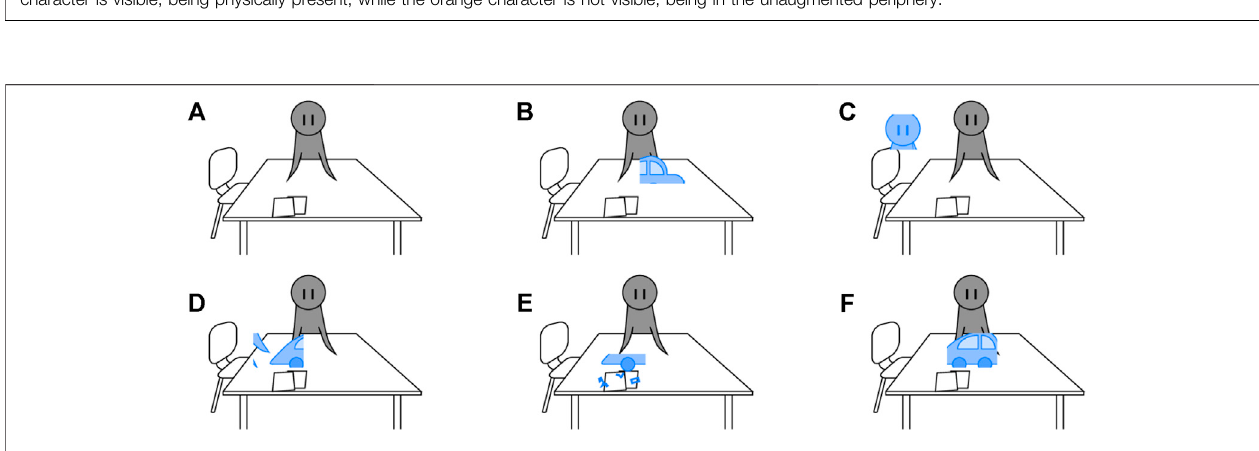
Frontiers in Virtual Reality |